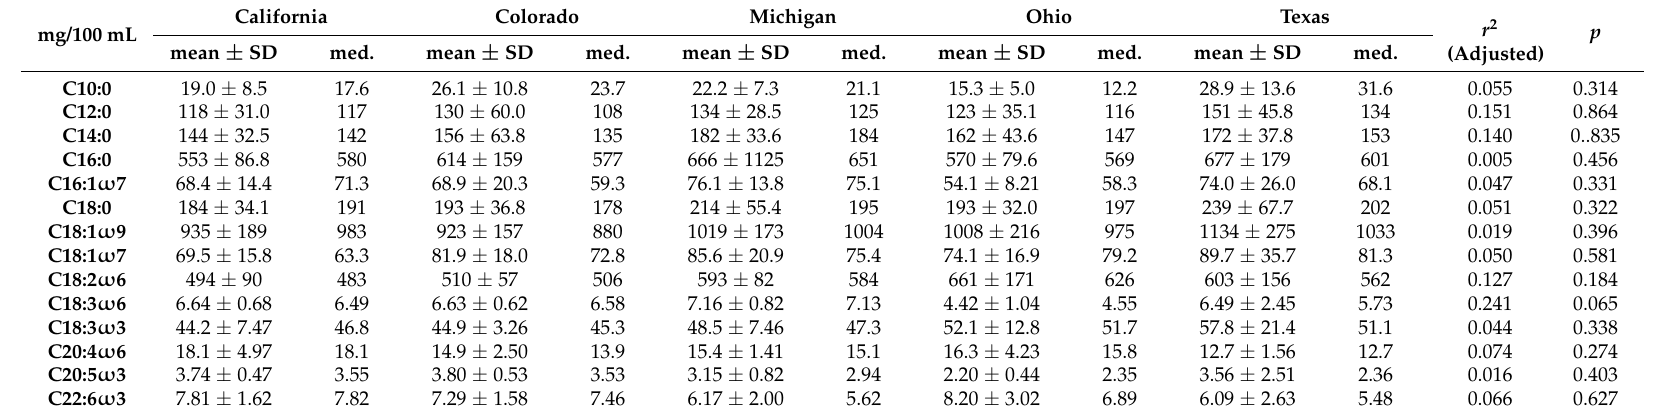
Table 2. Fatty acid levels in pooled samples obtained from Regional Milk